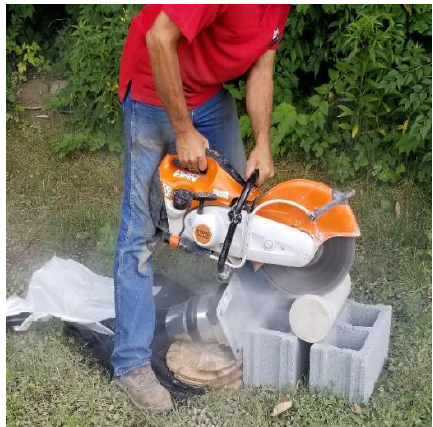
Figure 1. Image showing the dust collection method and